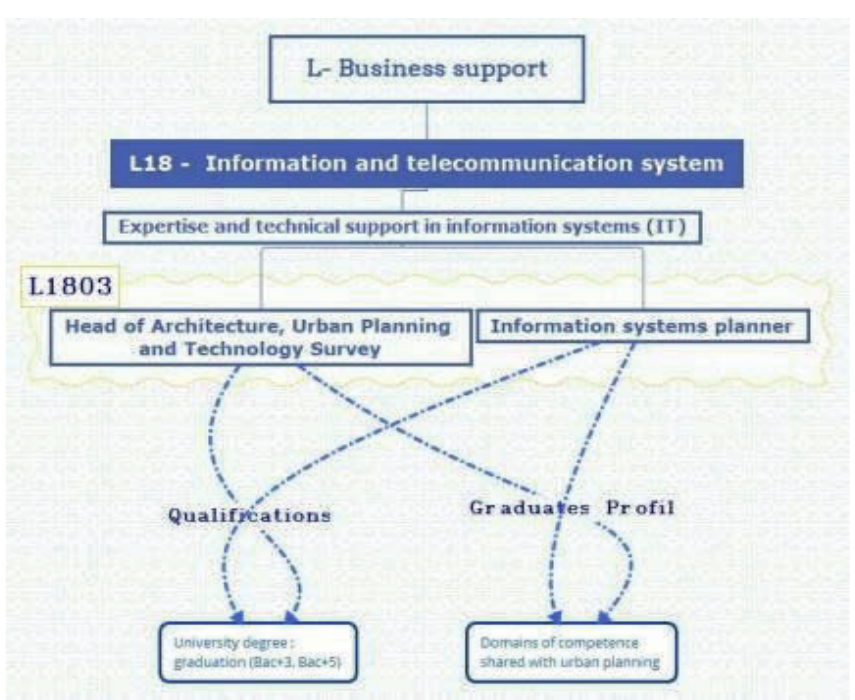
Fig. 4. Path and qualification requirements for access to urban planner trade on P1401 sheet (ANTP sheets, authors’ treatment,